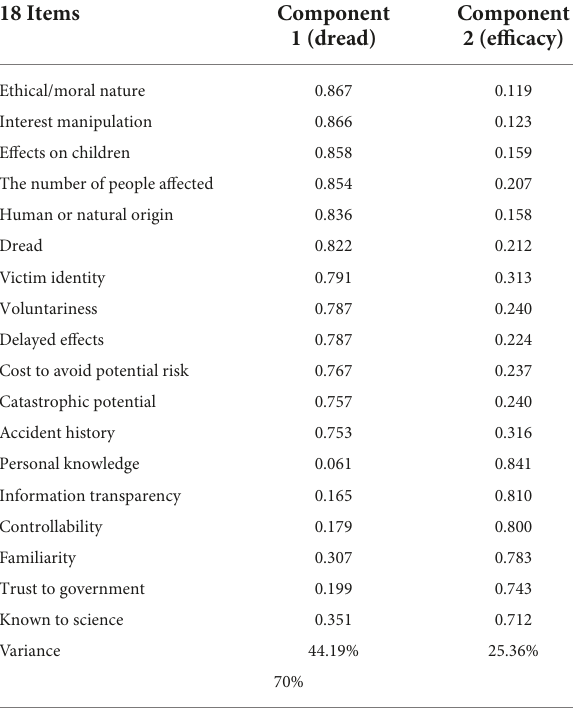
TABLE 2 Principal component analysis (rotated solution) after eliminating “fairness”.